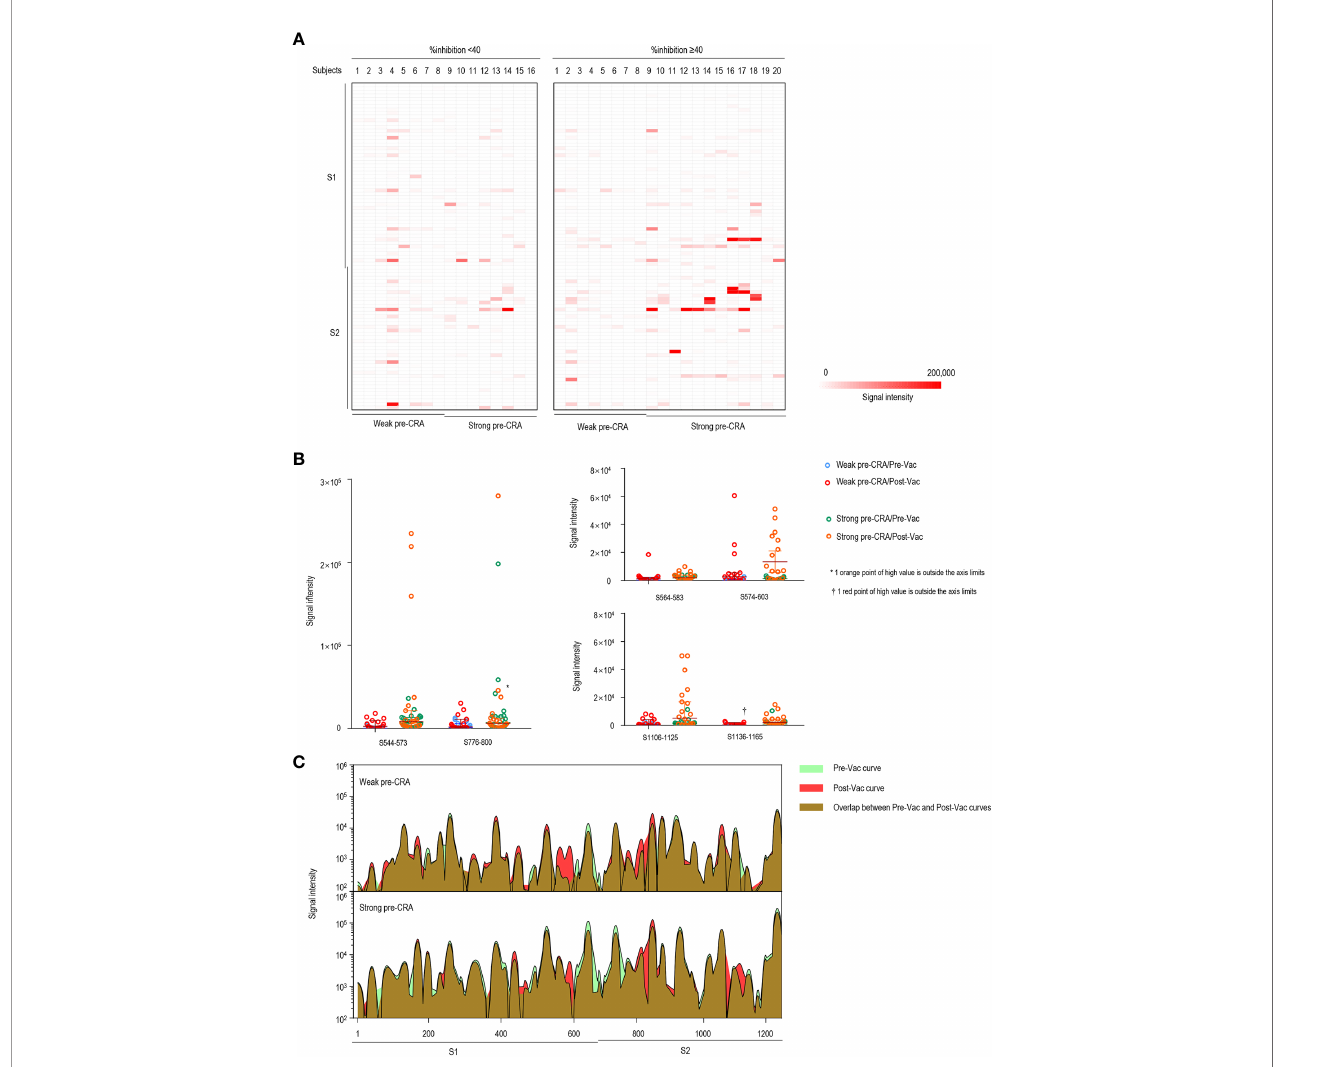
FIGURE 4 | The impact of pre-existing cross-reactive antibodies on vaccine-induced IgG response. (A) The IgG antibody responses to linear peptides of the S protein in vaccinated individuals. The heatmap is formed by subtracting the corresponding pre-vaccination fl uorescence readings from post-vaccination readings, representing the increase in fl uorescence intensity after immunization. (B) The changes in IgG signal intensities to six signi fi cant epitopes in paired sera before and after vaccine immunization, as separately shown in the strong pre-CRA and weak pre-CRA groups. (C) Global pro fi les of IgG responses to linear peptides of the S proteins in the strong pre-CRA (n=20) and weak pre-CRA (n=16) sera. The graphs are plotted as median values of the IgG responses to linear peptides of the S protein. Blue, pre-vaccination curve; Red, post-vaccination curve; Purple, the overlap between pre-vaccination and post-vaccination curves. Pre-Vac, pre- vaccination; Post-Vac,